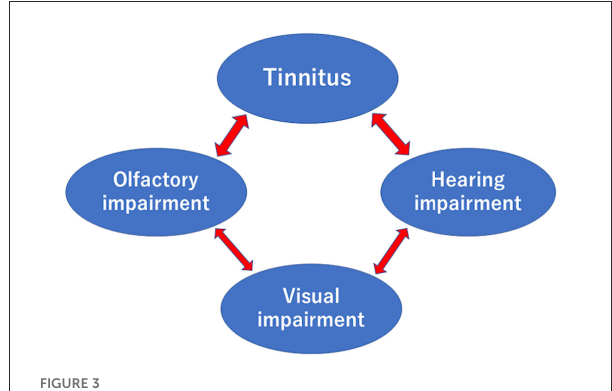
FIGURE3 Relationships between tinnitus, olfactory, hearing, and visual impairments after adjusting for age and sex. Arrows were recognized in this study.